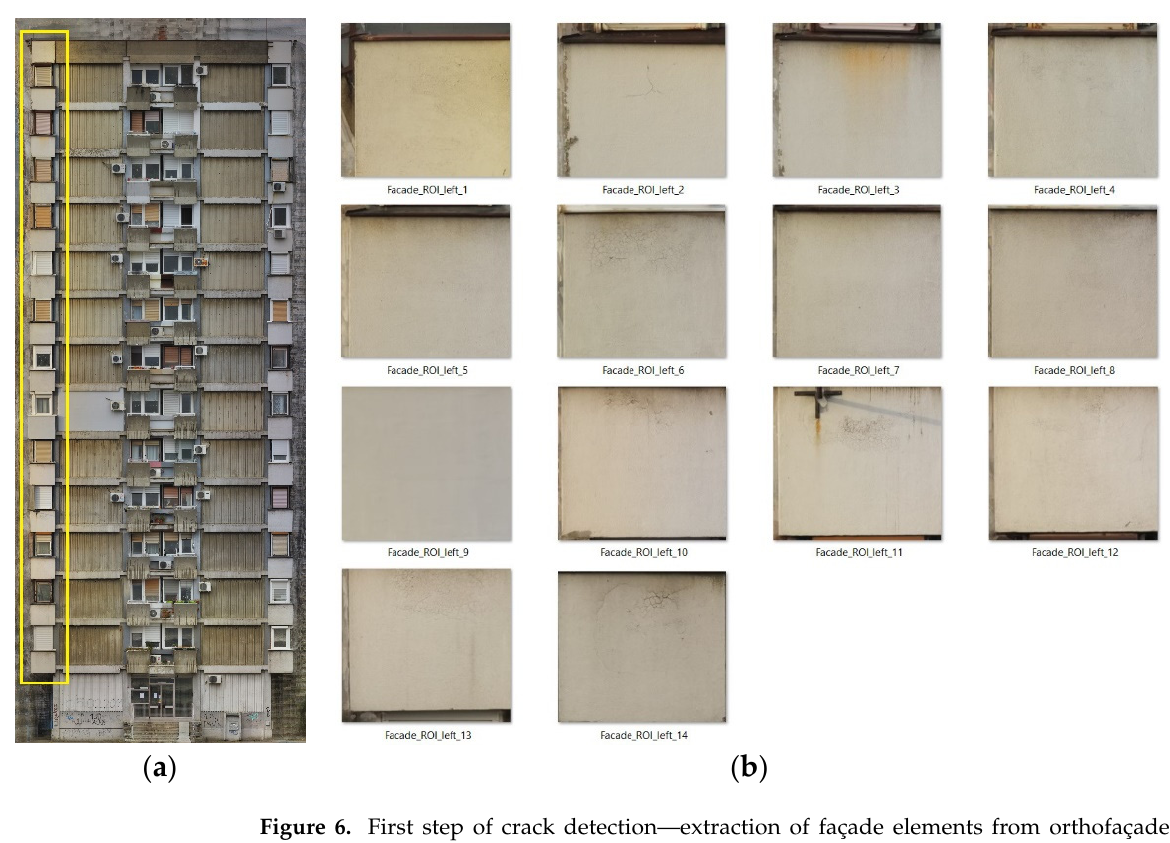
Figure 6. First step of crack detection—extraction of façade elements from orthofaçade image. ( a ) Façade elements selected for analysis; ( b ) the extracted individual blocks represented by rasters in the directory structure.